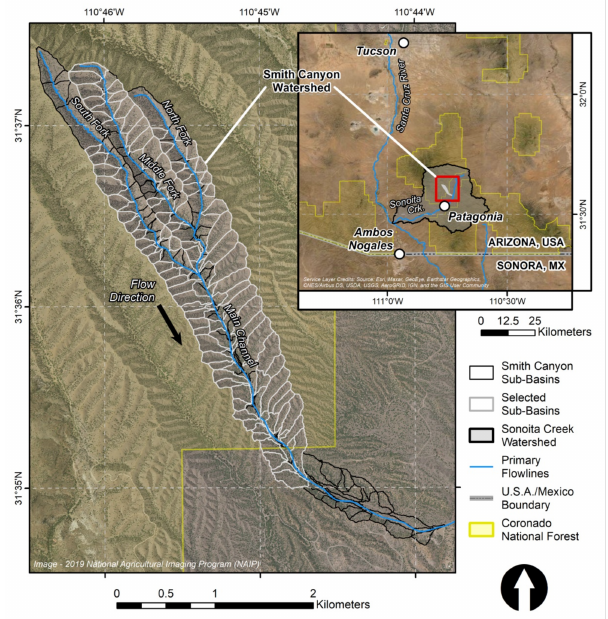
Figure 1. Locator map showing the location of Smith Canyon divided into the 225 total sub-basins (black). A total of 91 were selected for analysis (light gray). Much of Smith Canyon is located within the boundary of the Coronado National